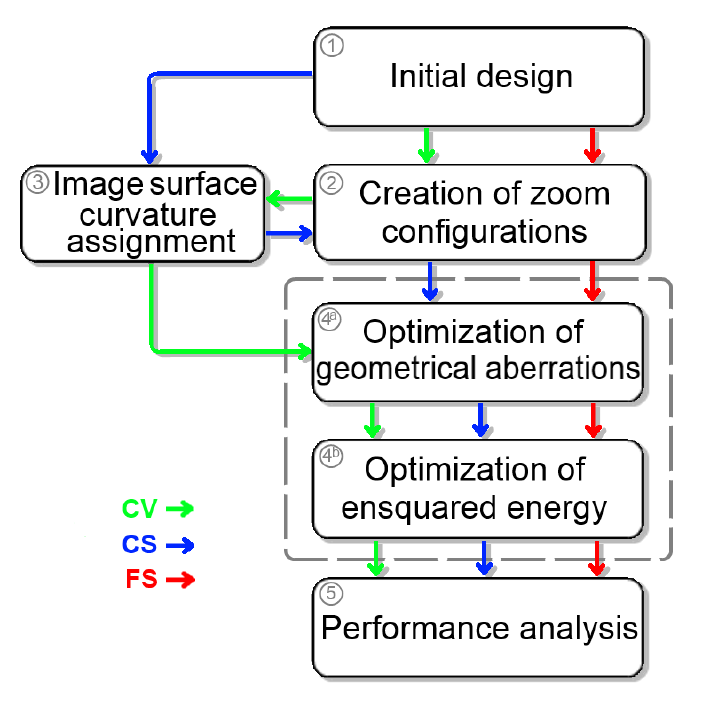
Figure 2. Design algorithm block diagram. The abbreviations indicate the detector configuration: “FS”, flat, static; “CS”, curved, static; “CV”, curved,